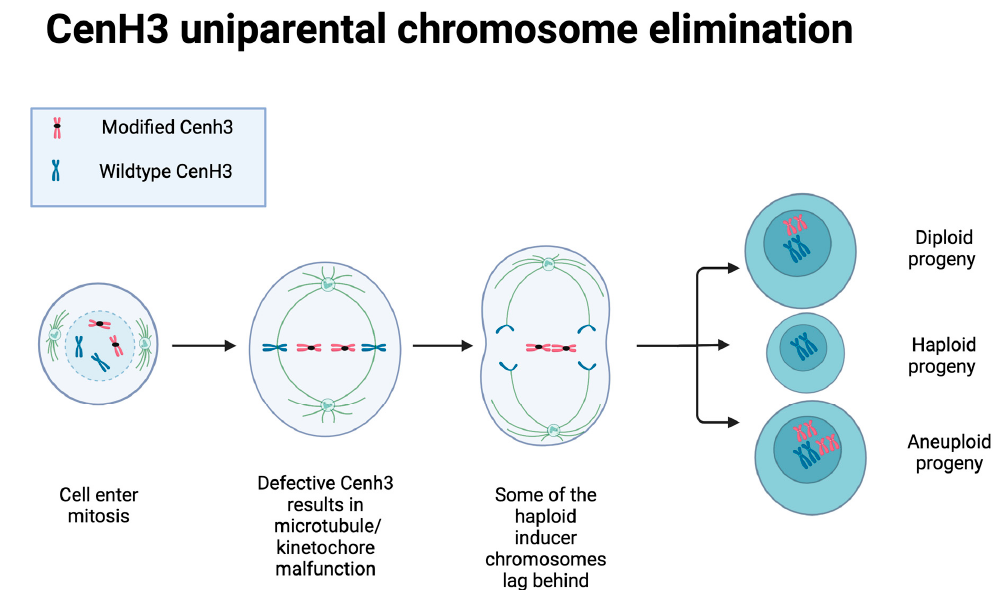
Figure 2. Illustration of centromere function during zygote mitosis. A plant with modified CenH3 gene is crossed with a wild-type plant resulting in uniparental chromosome elimination leading to haploid progeny and/or incomplete elimination of haploid inducer genetic material leading to aneuploid progeny (illustration adapted from Chan, 2010). Created with BioRender.com (accessed on 11 January 2023)